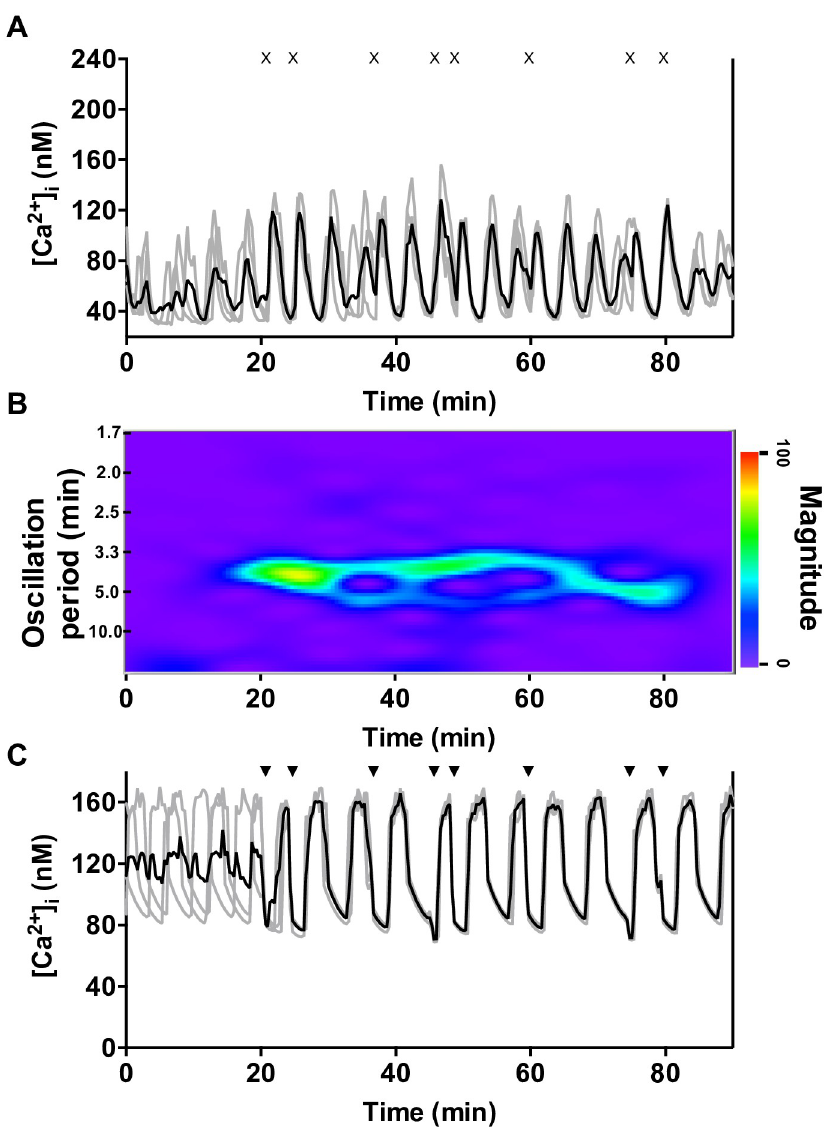
Fig 7. Synchronization of islets and model islets by randomly-spaced CCh pulses. A. The Ca 2+ traces (gray lines) from a representative experiment with a set of 4 islets are overlaid with the average [Ca 2+ ] i (black line). The timing of the CCh pulses are shown by an “x” above the figure. B. Although randomly spaced, the repeated CCh pulses produced a synchronized population as can be seen from the emergence of a coherent band in the spectrogram. Synchronization decreased shortly after the final pulse at 79 min. See S14 and S15 Figs for the remaining two groups of islets stimulated with randomly timed pulses of CCh. C. Four model islets (grey lines) are stimulated by an identical pattern of IP 3 pulses “ ▼ ” as the experiment shown in A. The resulting average (black line) demonstrates a synchronized population for the entire pulsing duration.